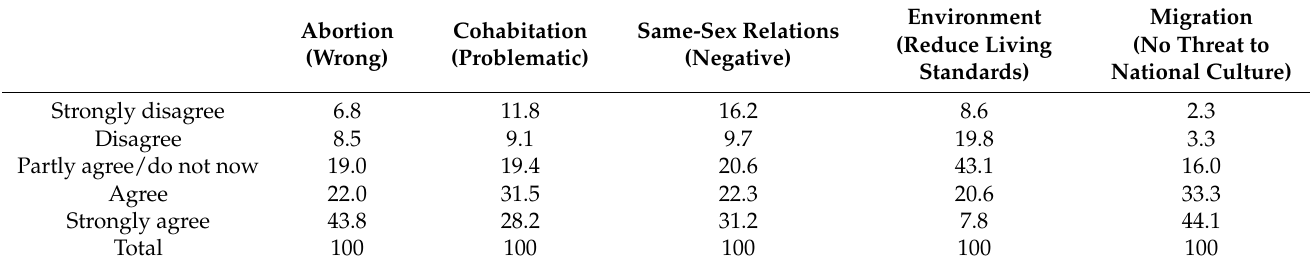
Table 1. Young evangelicals in Norway. Political attitudes, percent.